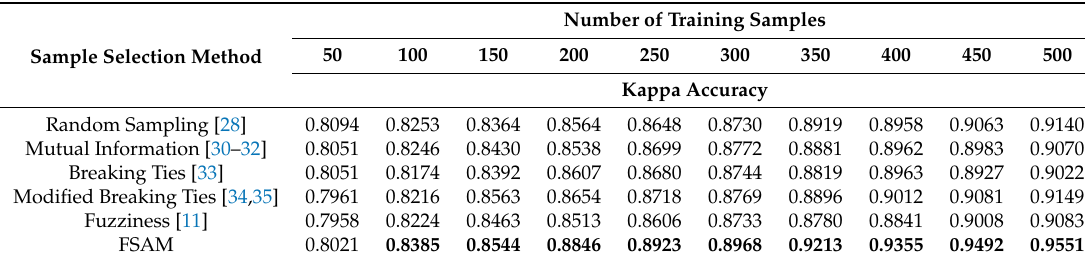
Table 5. Kappa ( κ ) accuracy obtained by ELM Classifier with different number of training samples selected in each iteration from Botswana dataset with different sample selection methods from literature.